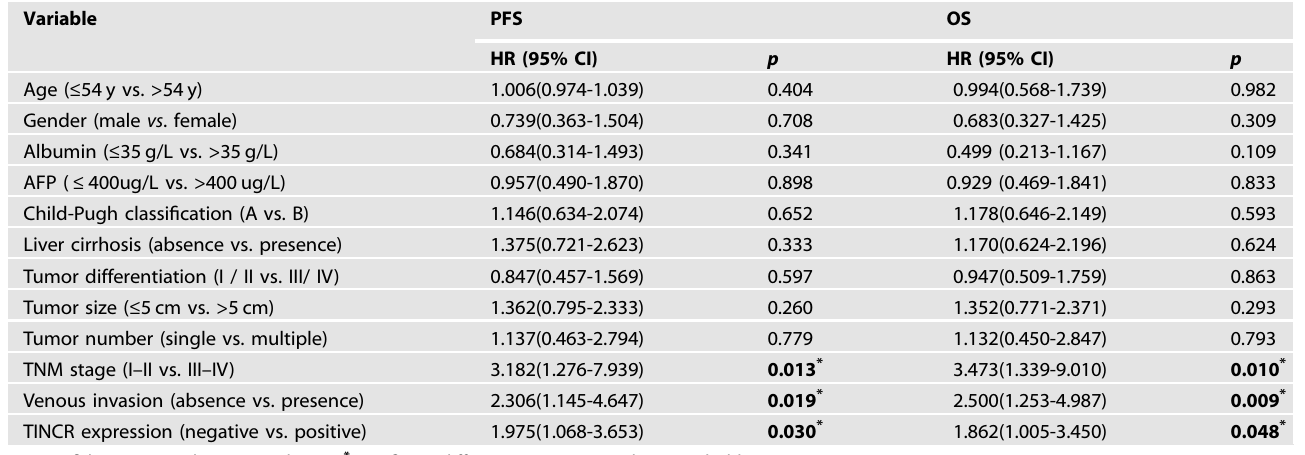
Table 2. Multivariate analysis by a Cox proportional hazards regression